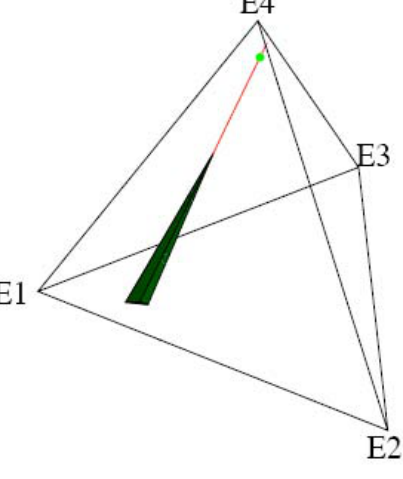
Figure 2. The set V is shown by the green pyramid. The red orbit connects ˆ x , the top of the 0 pyramid, the Nash equilibrium N and the target point N 1234 s by ˆ x and N 1234